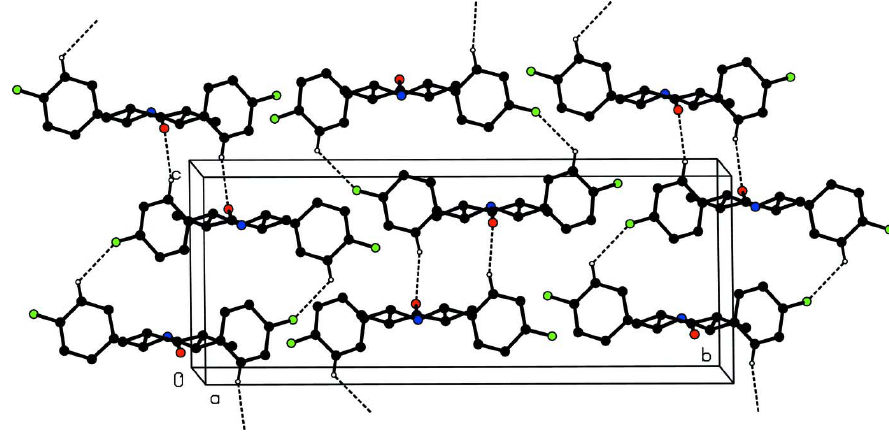
Figure 2 The molecular packing of (I), viewed down the a axis. For clarity, hydrogen atoms which are not involved in hydrogen bonding were